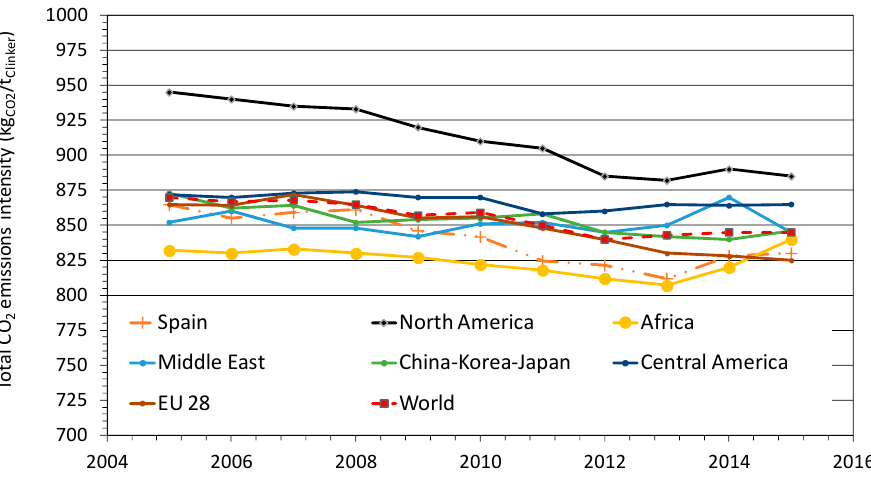
Figure 6. Gross carbon dioxide emissions for grey clinker from 2005 to 2015 [5].